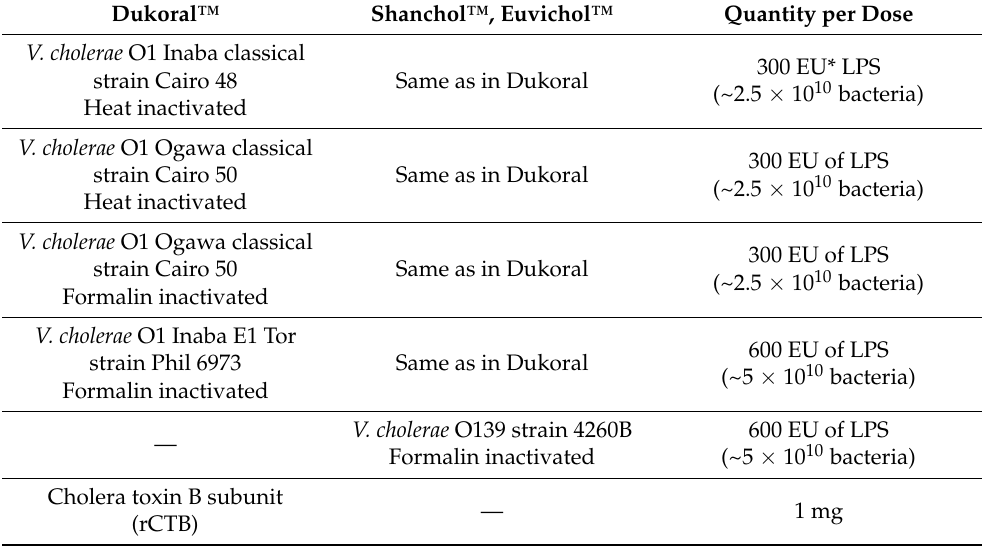
Table 1. Composition of WHO prequalified inactivated